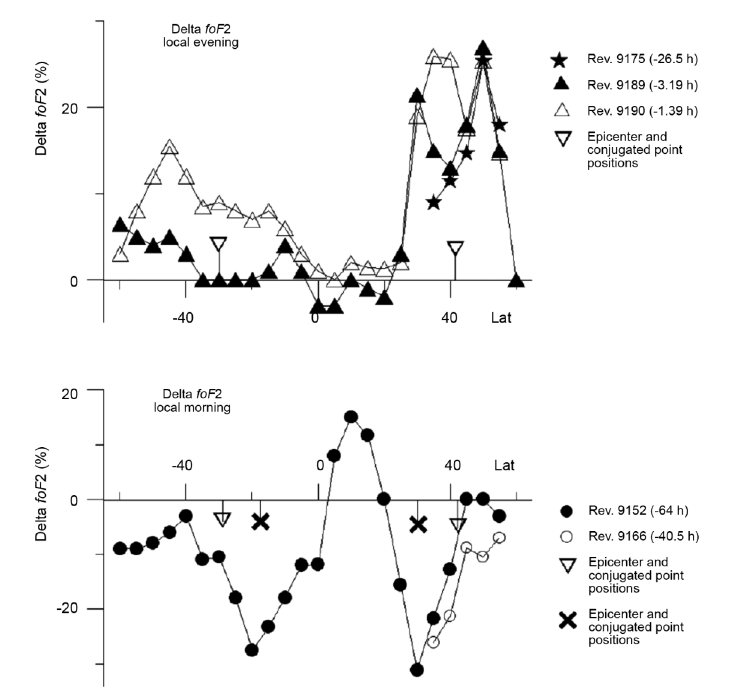
Fig. 8. Deviation of the critical frequency ∆ foF 2 for evening (upper panel) and early morning hours of local time for the passes of Intercosmos-19 satellite over Irpinia earthquake epicentral area and magnetically conju- gated